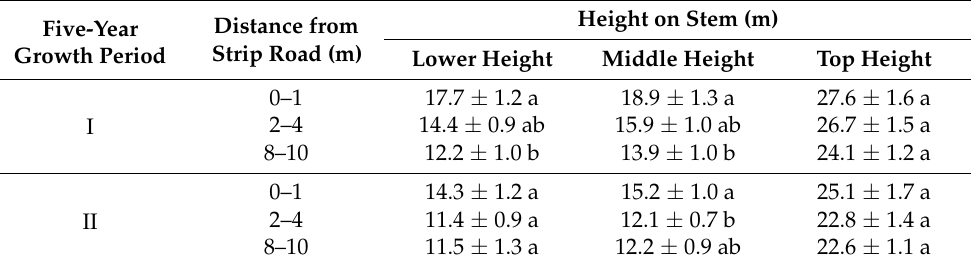
Table 1. Five-year growth in diameter (mm; mean values ± standard error (SE)) at lower, middle and top height zones related to the distance from the strip road in the 3.5 m variant. Height on Stem (m) Distance from Five-Year Strip Road (m) Growth Period Lower Height Middle